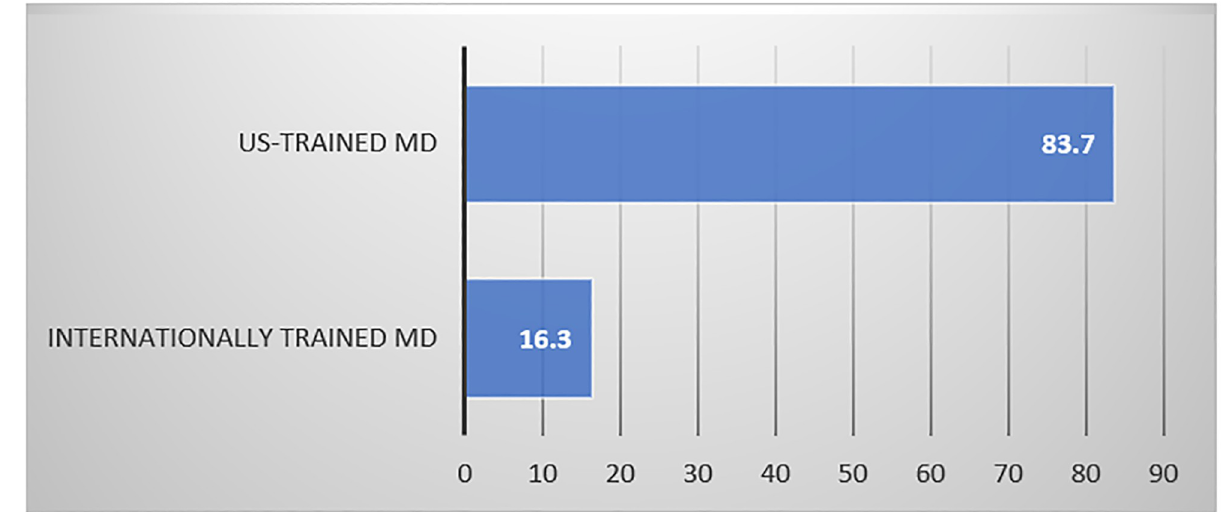
Fig 2. Percent of No VR uptake, by US trained compared to internationally trained physicians (P < 0.001).